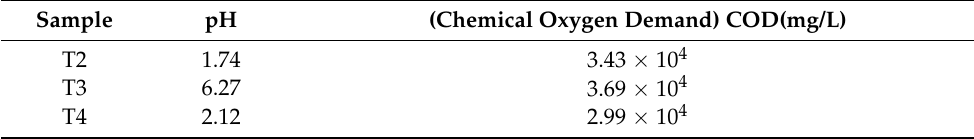
Table 1. Basic physicochemical parameters of non-metallic organic tanning agents (NOTAs).